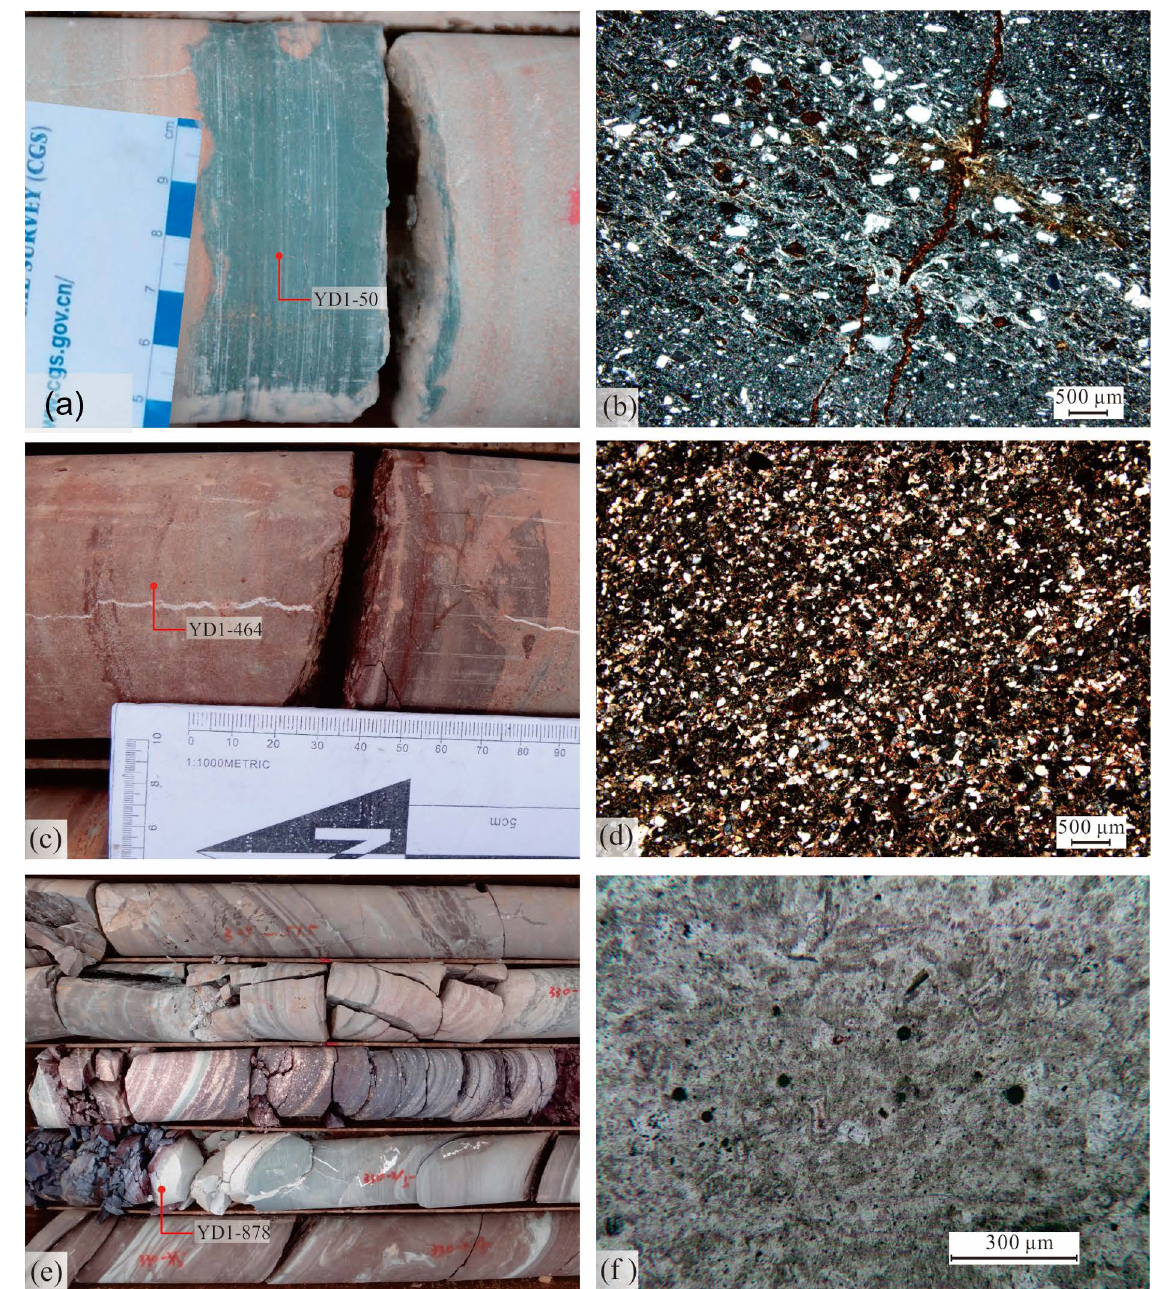
Figure 3. Photographs and microphotographs showing sampling core and its lithology. ( a ) Glassy crystal tuff (sample YD1-50), and ( b ) under transmitted light (sample YD1-50); ( c ) calcareous feldspar lithic sandstone (sample YD1-464), and ( d ) under transmitted light (sample YD1-464); and ( e ) rhyolitic tuff (sample YD1-878), and ( f ) under transmitted light (sample